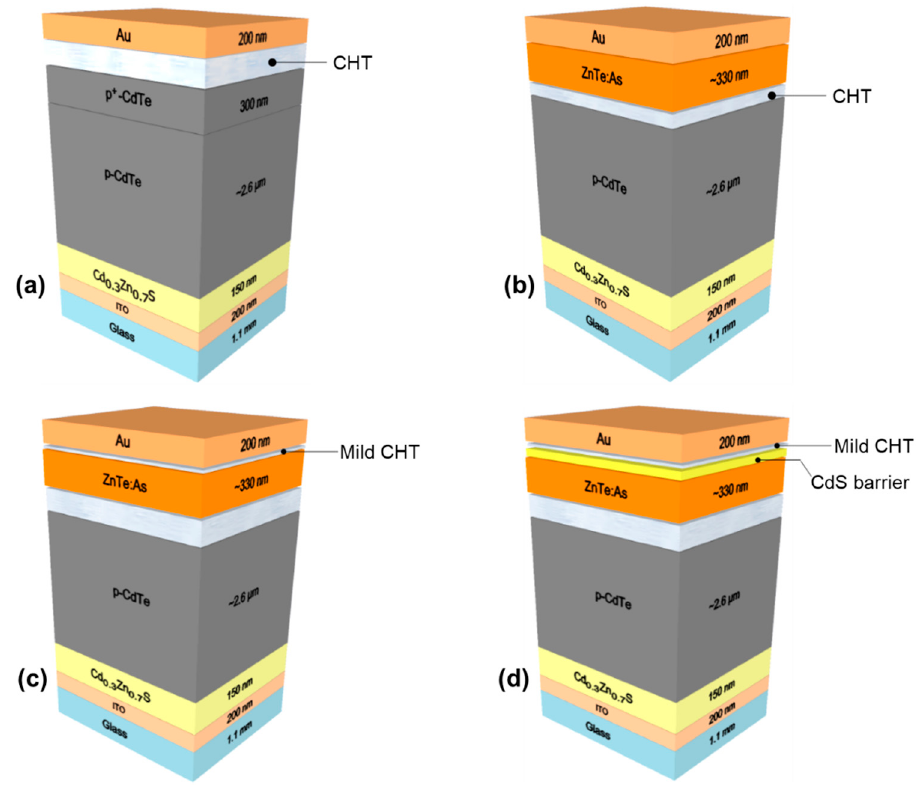
Figure 1. Schematic of ( a ) baseline CdTe cell; ( b ) ZnTe:As back-contacted CdTe cell, and ( c ) ZnTe:As back contacted cell with mild Cl-anneal without a CdS sacrificial layer ( d ) ZnTe:As back contacted cell with mild Cl-anneal using a CdS sacrificial layer (not to scale).